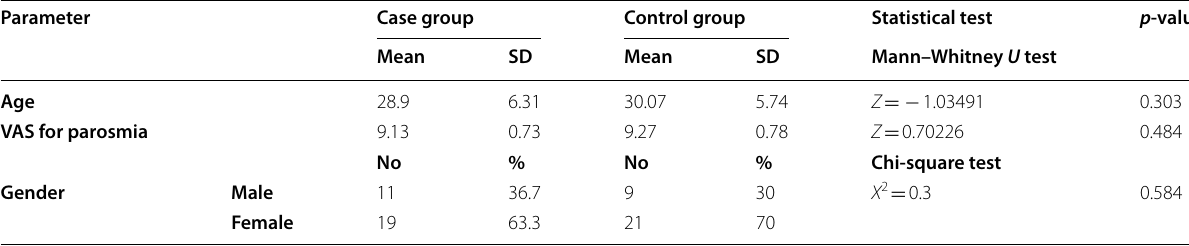
VAS Visual analog scale